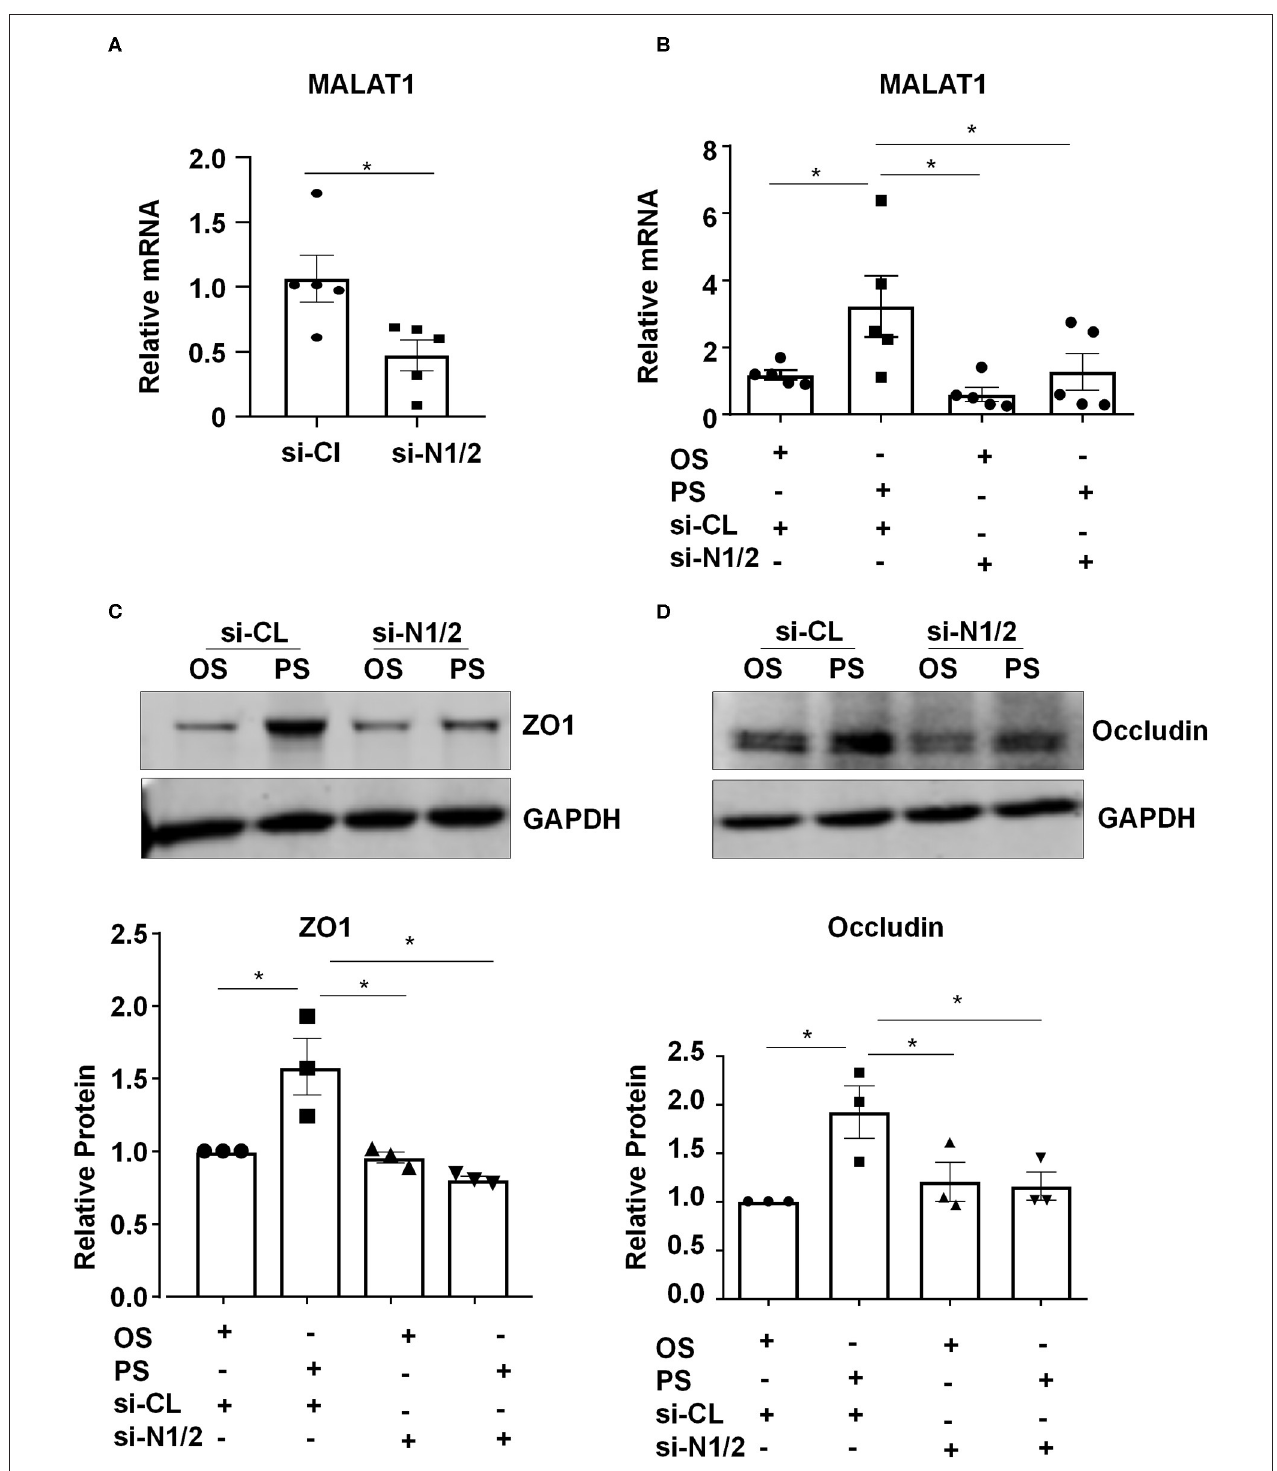
FIGURE 3 | Components of the linker of nucleoskeleton and cytoskeleton (LINC) complex, Nesprin1 and Nesprin2, are required for upregulating the expression of MALAT1, ZO1, and Occludin by pulsatile shear (PS). (A) HUVECs were transfected with siRNAs targeting Nesprin1 and Nesprin2 (si-N1/2) (60 nmol/L) or control siRNA (si-CL), and the expression of MALAT1 was analyzed by qRT-PCR. (B–D) HUVECs were transfected with si-N1/2 or si-CL and were then exposed to PS or OS for 6h, and the expressions of MALAT1, ZO1 and Occludin were analyzed by qRT-PCR and Western blot. In (C,D) , semi-quantification of the blots are shown in the lower panels. One-way ANOVA, * P < 0.05 compared with the indicated controls.